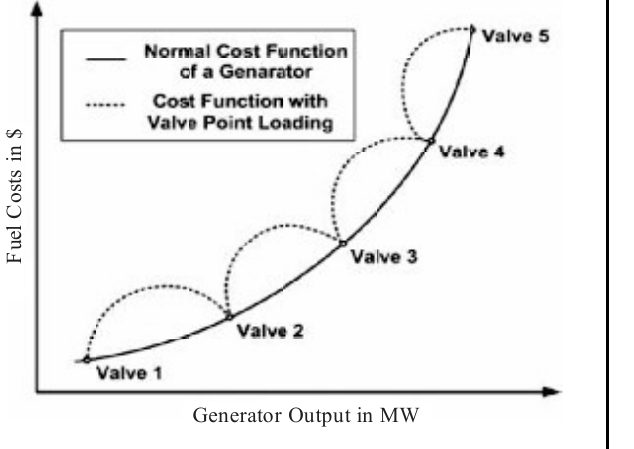
FIG. 1(b). FUEL COST CURVE REPRESENTING THE PROHIBITED OPERATING